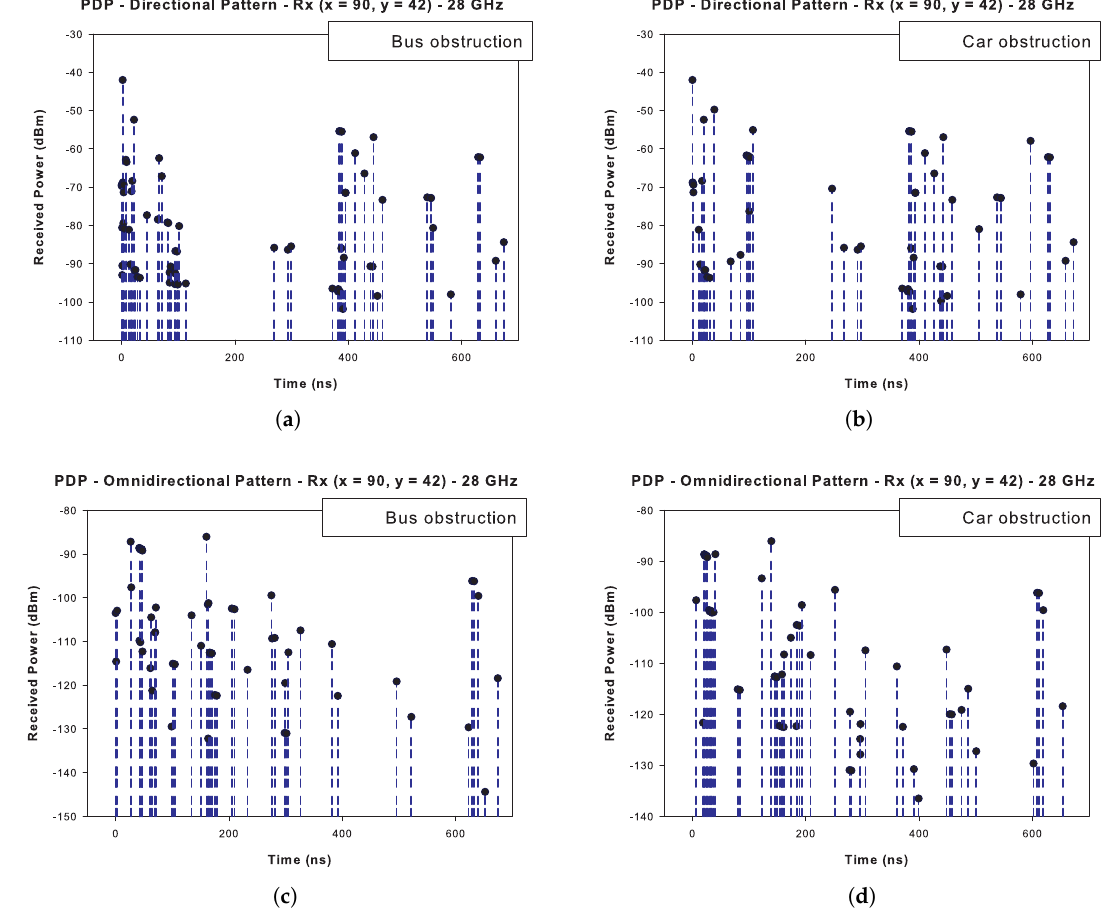
Figure 14. Power Delay Profile (dBm) at 1.5 m height: ( a ) Directional radiation antenna pattern and bus obstruction, ( b ) Directional radiation antenna pattern and car obstruction, ( c ) Omnidirectional radiation antenna pattern and bus obstruction, ( d ) Omnidirectional radiation antenna pattern and car